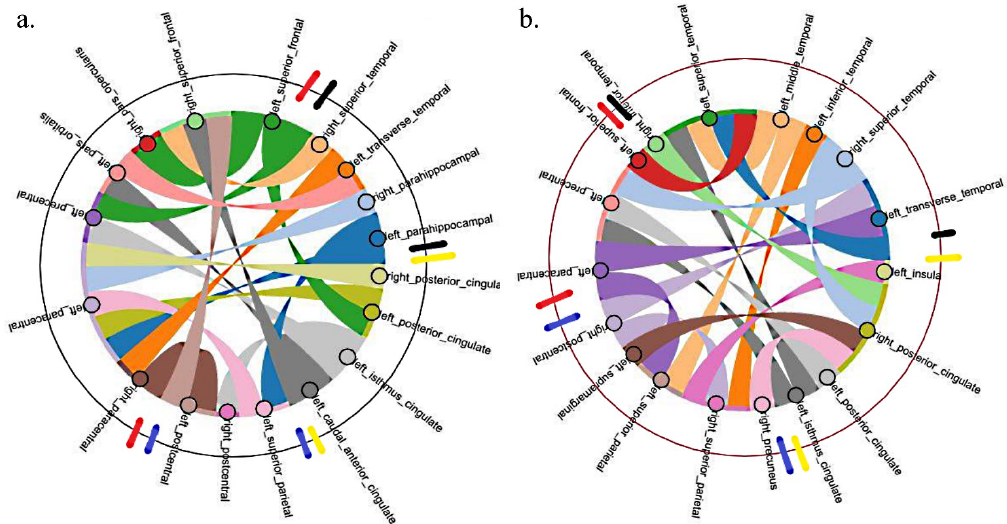
Figure 6. Shows top 18 (in terms of highest GRAD-CAM heatmap values) WM neural connections considered from the respective heatmaps of LGG and HGG patients. a. LGG (left) b. HGG (right). Legends in red ( ) shows frontal lobe regions, black ( ) shows temporal regions, yellow ( ) shows cingulate cortex, and blue ( ) shows parietal regions of the brain. The chord plot was developed using the HoloViews package (Python version 3.9.7). The color of the arcs/ribbons in the